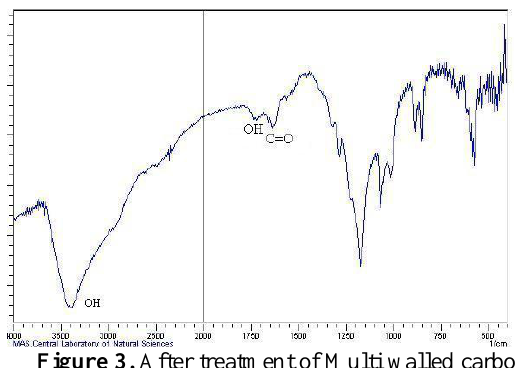
Figure 3. After treatment of Multi walled carbon nanotube with sulfuric and nitric acid by IR